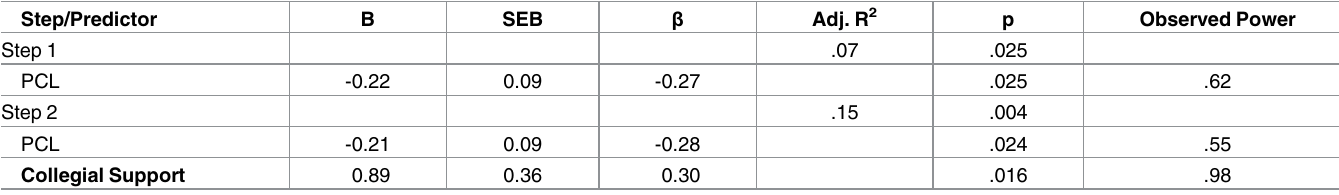
Table 6. Regression analysesfor hypothesis 4: Criterion variable for all analysesis Job in General (job satisfaction). Step/Predictor